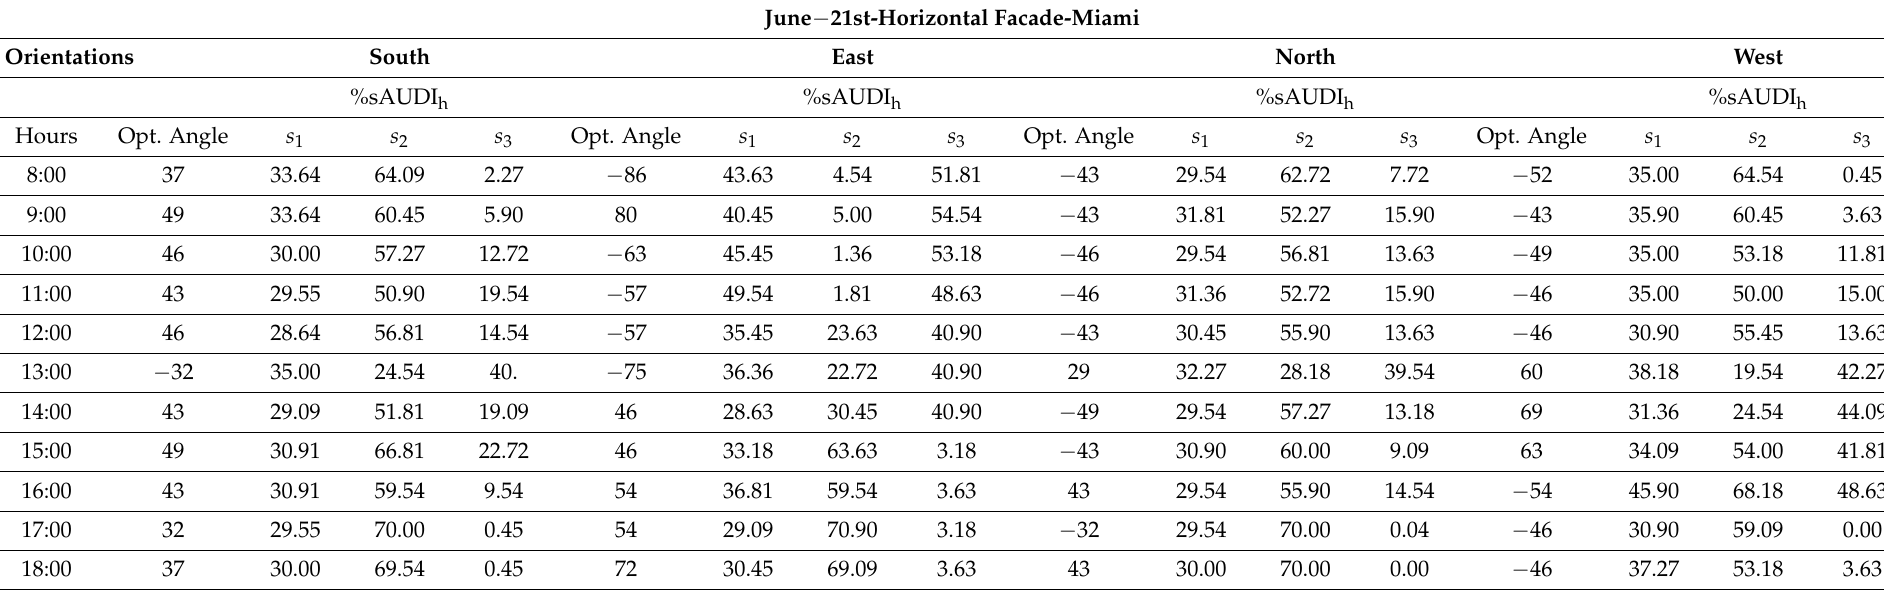
Table 6. The hourly optimum angles and their associated %sAUDI h on 21 June in Miami − Horizontal Louvers. June − 21st-Horizontal Facade-Miami